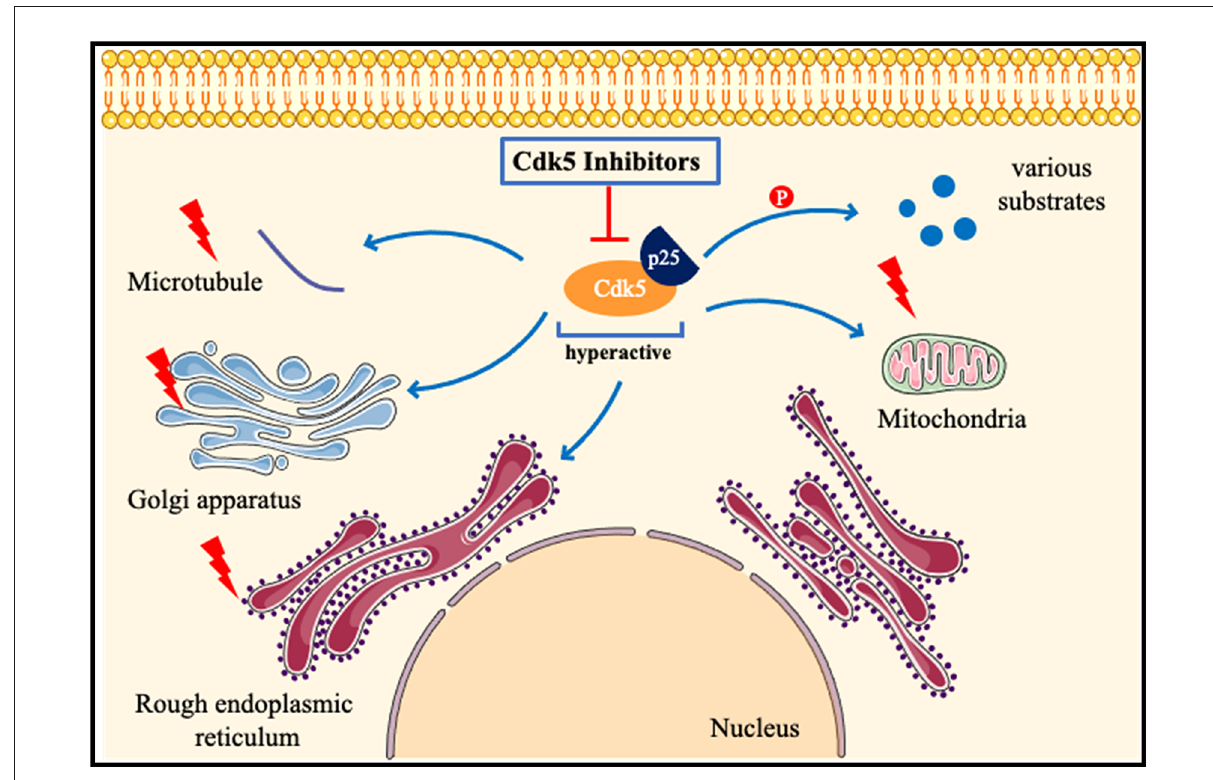
FIGURE4 Pathological mechanisms of Cdk5 in neurological disorders. When neurons are subjected to pathological stimuli, such as ischemia and toxic injury. Cdk5 is highly activated after binding to p25, phosphorylates many substrates, and also induces mitochondrial fragmentation, Golgi apparatus and endoplasmic reticulum dysfunction, and destruction of the cytoskeleton. Cdk5 inhibitors can attenuate or even reverse the above pathological